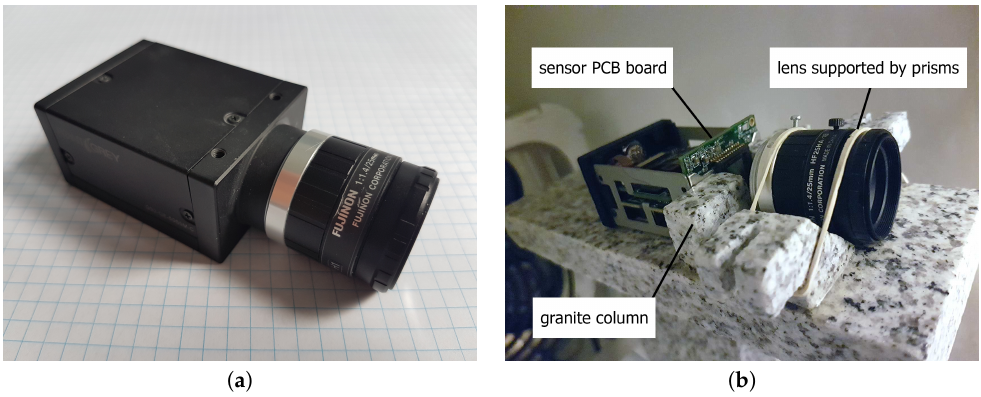
Figure 7. The original and modified camera unit. ( a ) The original camera unit. ( b ) A photo of the modified camera. The lens is positioned on two granite prisms while the sensor is supported between two granite columns and can only translate along the vertical sensor axis and rotate around the horizontal sensor axis.